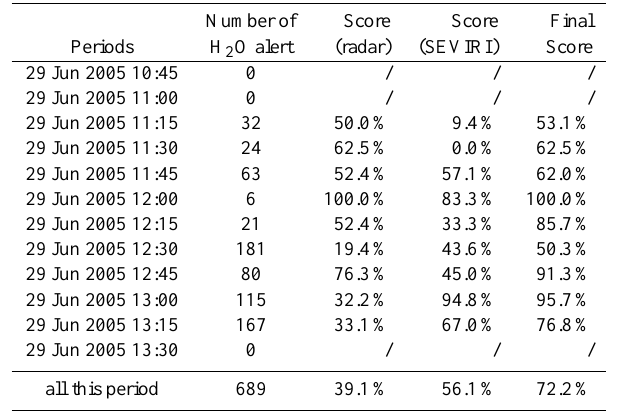
Table 2. Statistical results between 10:45 and 13:30UTC on 29 June 2005. For each H 2 O alert (pixel), if deep convection is in- dicated by radar and/or SEVIRI, one count is obtained. Final scores are set with a normalisation in percentage.